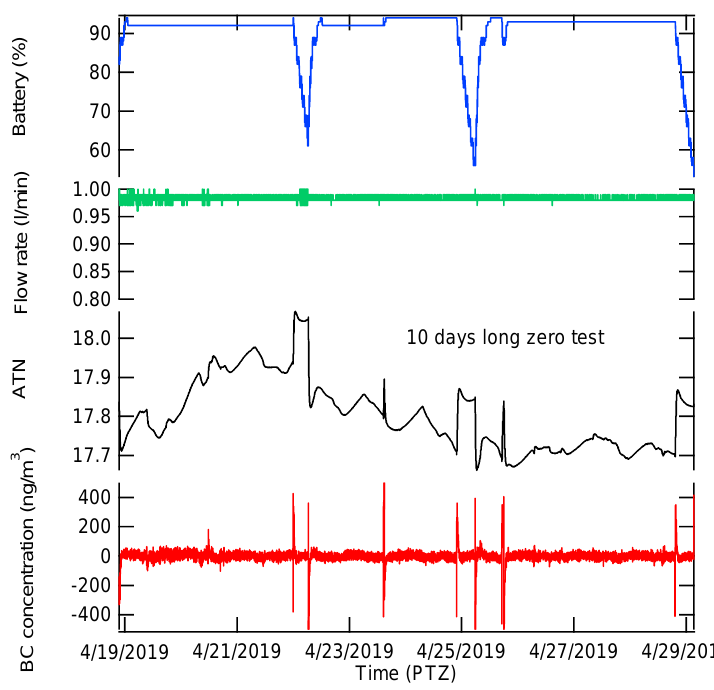
Figure 11. Long term zero test using filter-cleaned particle free air. Black carbon (BC) concentration, attenuation (ATN) and Flow rate are shown together with battery status.